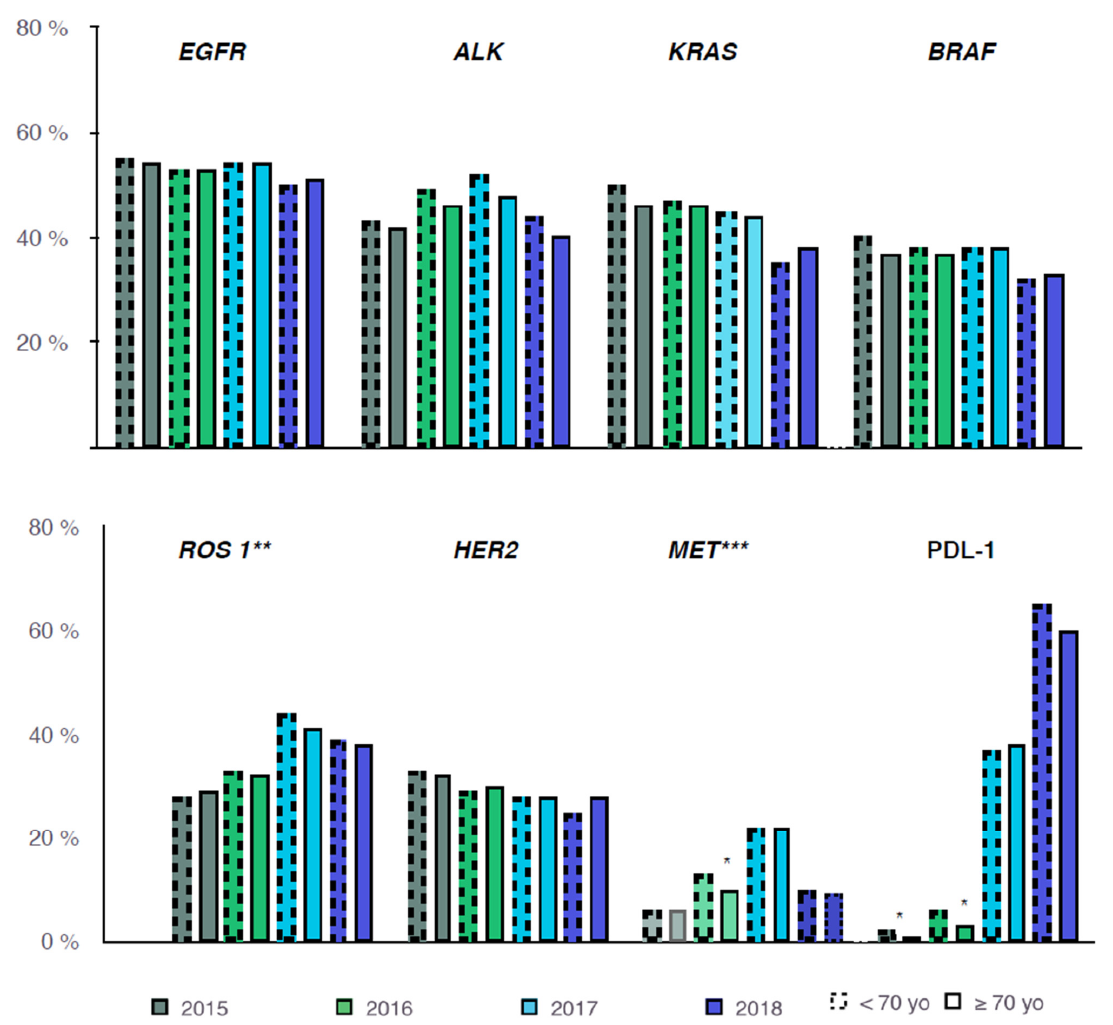
Figure 3. Biomarker testing rate according to age (<70 yo and ≥ 70 yo) over time. EGFR, epidermal growth factor receptor; ALK, anaplastic lymphoma receptor tyrosine; HER2, Human Epidermal growth factor Receptor 2; PDL-1, programmed cell death ligand 1. Positive result for PDL-1 meant a tumor proportion score > 1%. «Molecular testing only», meaning testing for at least one molecular alteration excluding the search for PD-L1 status, were stable all over years. * p < 0.01, ** ROS1 mutation and/or rearrangement, *** MET mutation and/or amplification. Comparing patients screened and not screened (Table 1), those who had tumor biomarker testing were more likely to be female